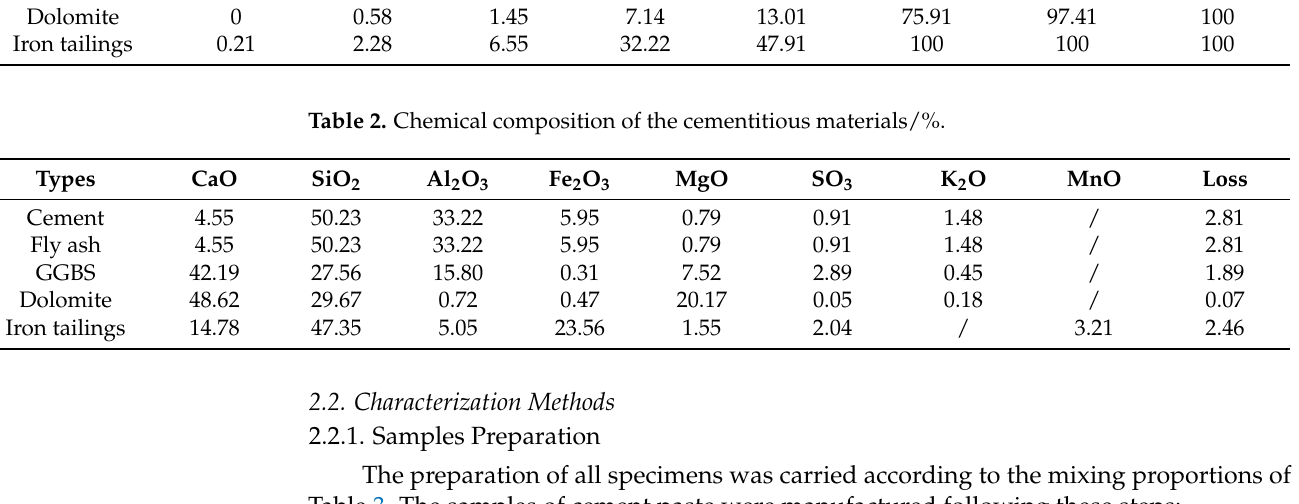
Table 3. The samples of cement paste were manufactured following these steps: Table 3. Mix proportion of the cement paste or concrete/kg/m 3